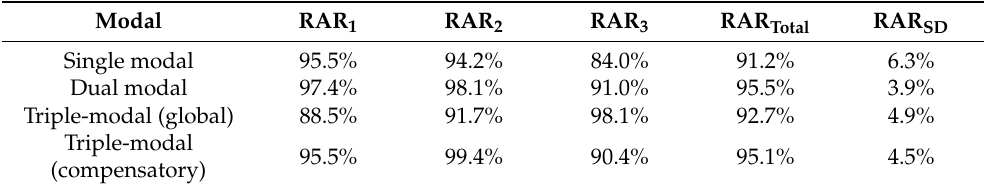
Table 9. Validation discrimination effect of the four optimal joint models based on the fusion of single-modal or multi-modal models.